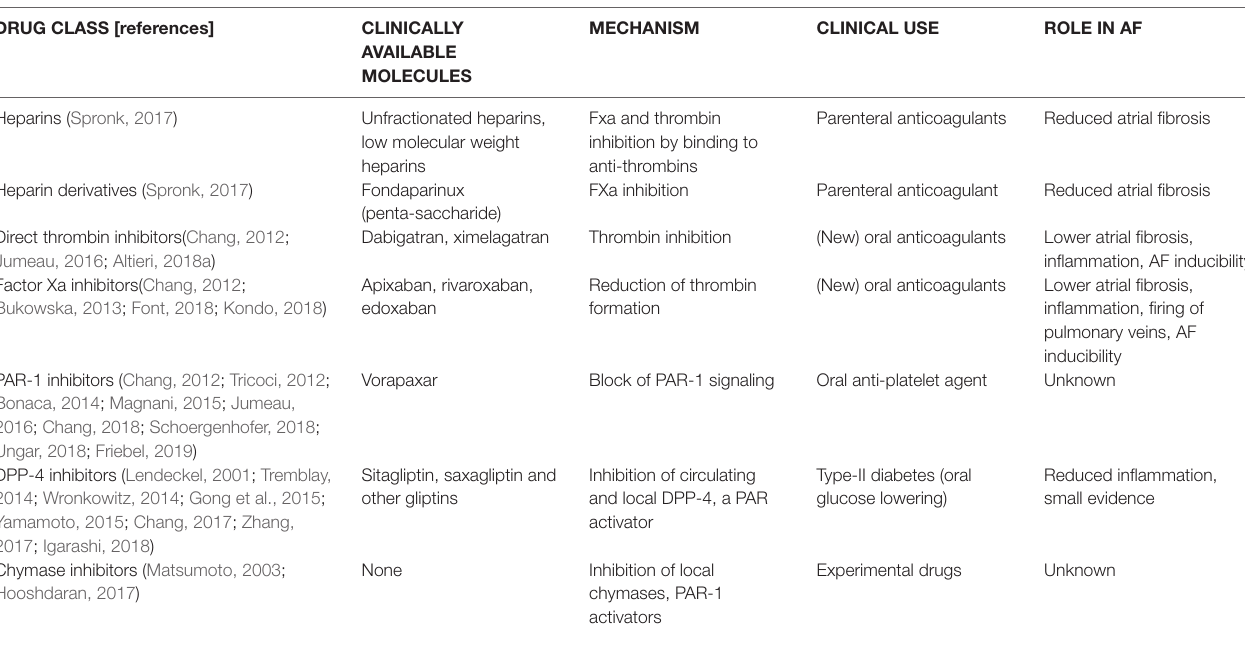
TABLe 1 | Drugs acting on PAR